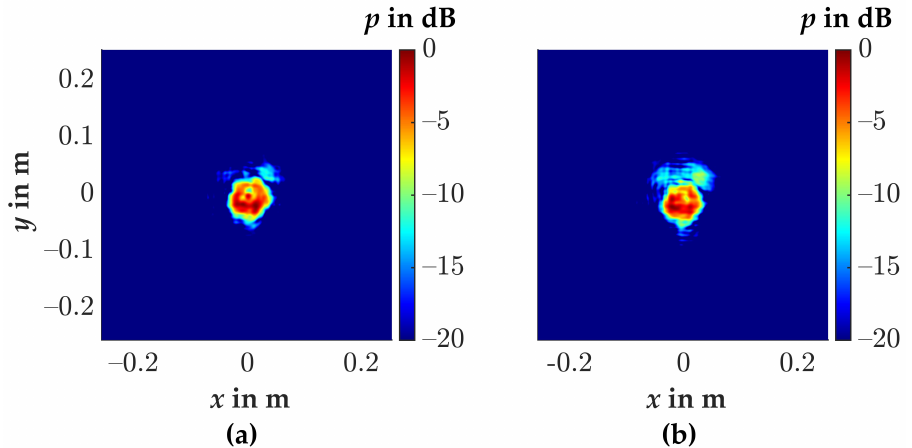
Figure 10. Evaluation result on the top surface of the wooden particleboard, with ( a ) 10 mm and ( b ) 6 mm under the particleboard. The results were evaluated at a frequency of 50 kHz.